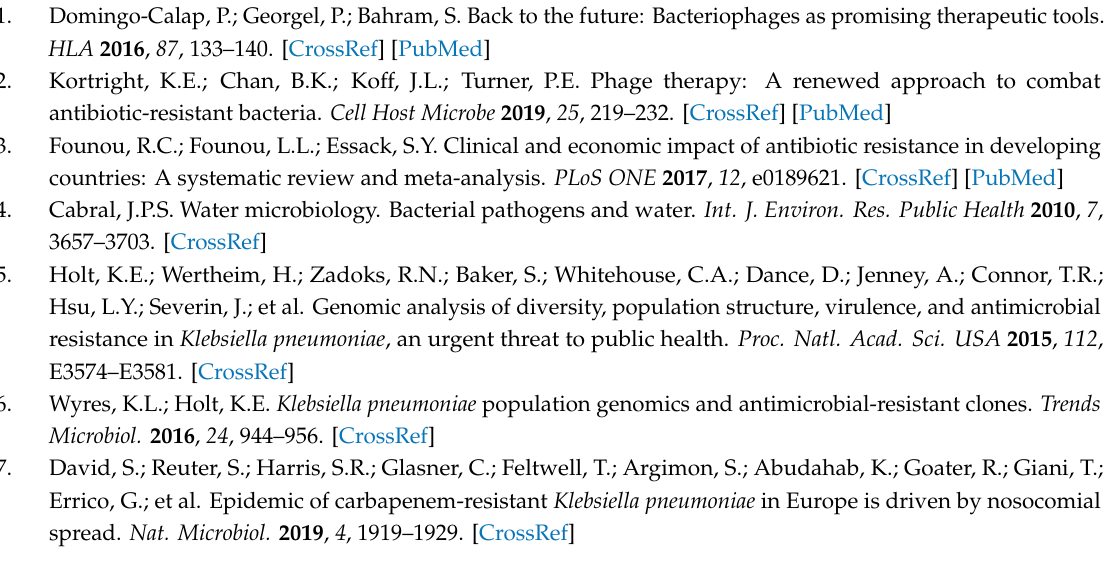
Table S1: Functional annotation of Klebsiella phages π VLC1-4 and orthology results. Table S2: Clinical isolates of carbapenem-resistant K. pneumoniae strains used in this